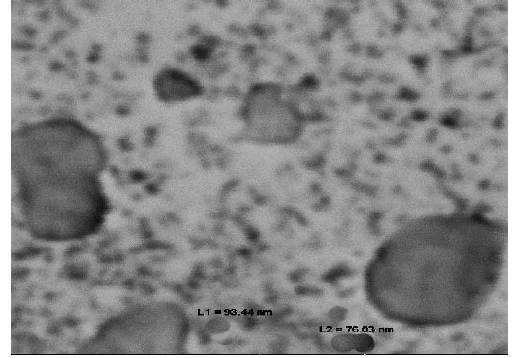
Figure, 4: Crystalline clusters of SNPs obtained by scanning electron Microscopy (4000X) This study provided evidence that the leaves and flowers of the SO. were good sources for synthesizing stable SONPs in lesser time. The change in color was due to reduction of silver ions indicating SNPs.